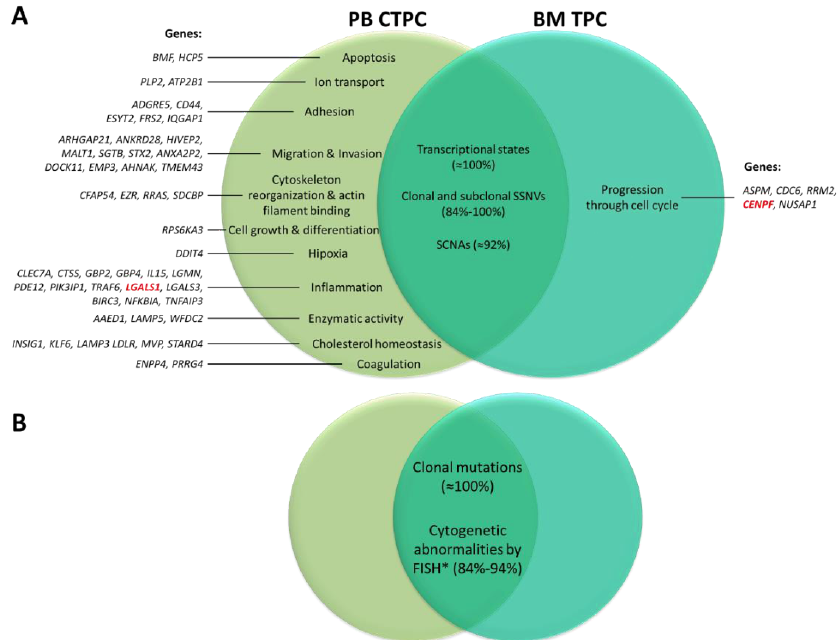
Figure 4. Differential gene expression profile ( A ) and genetic alterations ( B ) of blood circulating tumor plasma cells (CTPC) compared to paired bone marrow (BM) TPC in MM. The light green circle represents the most relevant genes differentially expressed in blood CTPC vs. BM TPC. In turn, the dark green circle represents genes differentially expressed in BM TPC vs. their blood counterpart. The intersection of both circles indicates the genetic profile shared between blood CTPC and BM TPC. Genes depicted in red have been reported as independent prognostic factors for progression-free survival and overall survival in MM. * Cytogenetic alterations involve del17p, t (4;14), t (14;16). Clonal mutations refer to genes such as KRAS, NRAS, BRAF and TP53 . FISH, fluorescent in situ hybridization; MM, multiple myeloma; PB, peripheral blood; SCNAs, somatic copy-number alterations;